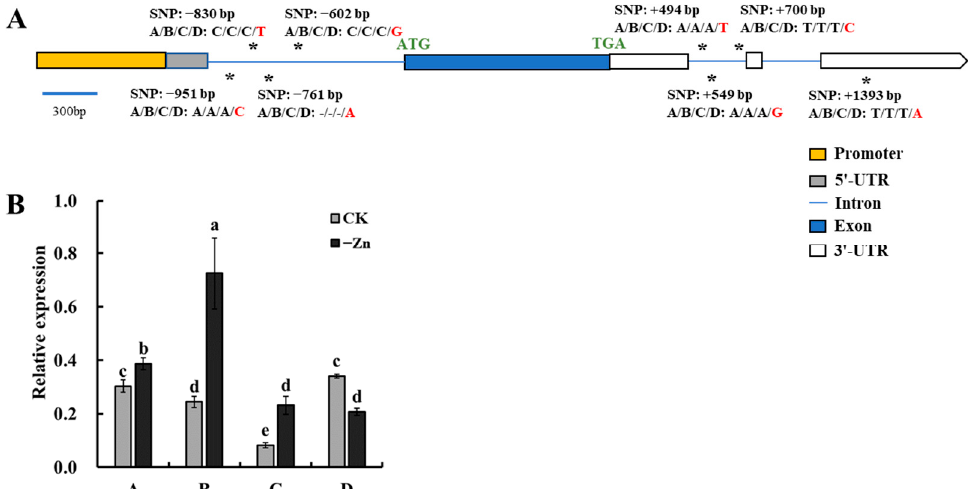
Figure 6. Sequence and expression of LOC_Os02g06010 in the four parental lines of the MAGIC population. ( A ) Gene structure of LOC_Os02g06010 and polymorphism locations (*: SNP). The SNPs are underlined with asterisks. ( B ) Relative expression of LOC_Os02g06010 in four parental lines under different Zn 2+ concentrations. The seedlings of four parental lines at three-leaf stage, grown in the 1/4 strength IRRI solution with 0.77 µ M Zn 2+ (CK) or without Zn 2+ (-Zn) were used. RNA was extracted from rice roots. Values are mean ± SE (n = 3). The different letters above the bars indicate significant difference between the control and treatments at p < 0.01.